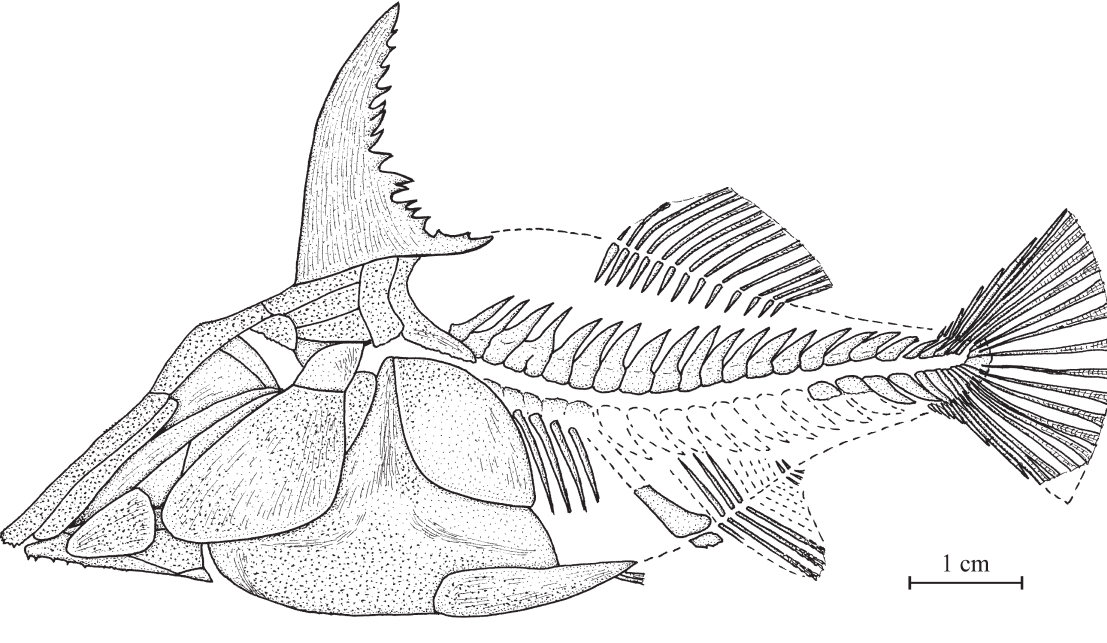
Fig. 8. Monocerichthys scheuchzeri gen. et sp. nov. General reconstruction based on the two faces of holotype CLC S-413a, b. Body scales are